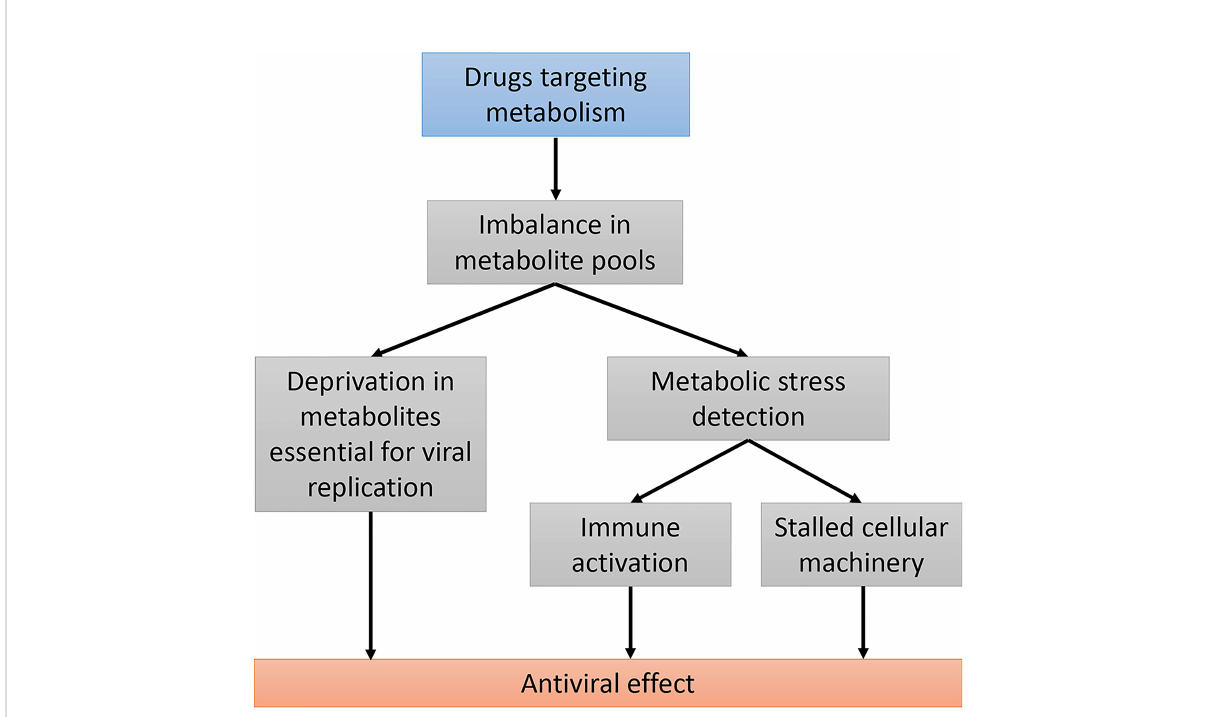
FIGURE 2 Using drugs targeting host metabolic pathways as an antiviral strategy. Modifying host cell metabolism using drugs will alter the balance in several metabolite pools. This can primarily prevent viral replication by depletion in essential metabolites. These metabolic changes can be detected by cellular metabolic sensors and have an impact on both the innate immunity response and the cellular machinery. Stalled cellular machinery could both enhance the antiviral immune response and prevent viral